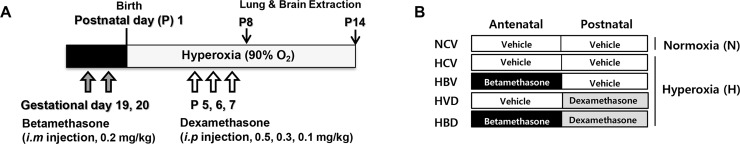
Experimental protocol.(A) Schematic outline of the animal model of antenatal and postnatal steroids-exposed newborn rat pups under hyperoxia. (B) Experimental study groups. NCV, normoxia control with antenatal vehicle and postnatal vehicle; HCV, hyperoxia control with antenatal vehicle and postnatal vehicle; HBV, hyperoxia with antenatal betamethasone and postnatal vehicle; HVD, hyperoxia with antenatal vehicle and postnatal dexamethasone; and HBD, hyperoxia with antenatal betamethasone and postnatal dexamethasone.